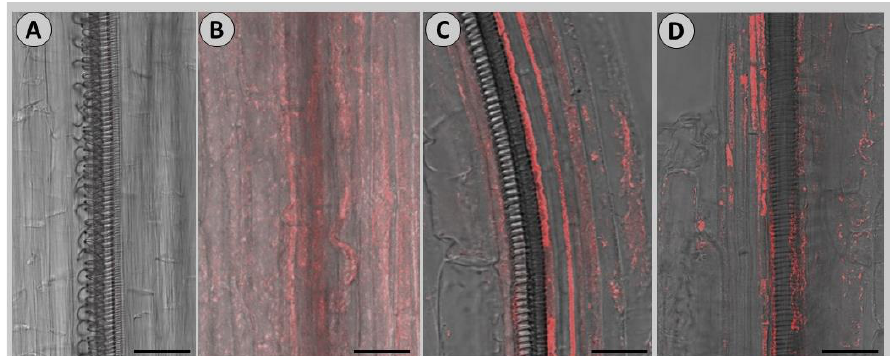
Figure 2. Calibration of FISH protocol for garlic leaf tissues. Scale = 80 µm . ( A ) Control, no probe. ( B ) Probe concentration 3 pmol/mL, overnight hybridization at 25 or 37 ◦ C. ( C ) Probe concentration 3 pmol/mL, overnight hybridization at 50 ◦ C. ( D ) Probe concentration 5 pmol/mL, overnight hybridization at 50 ◦ C.